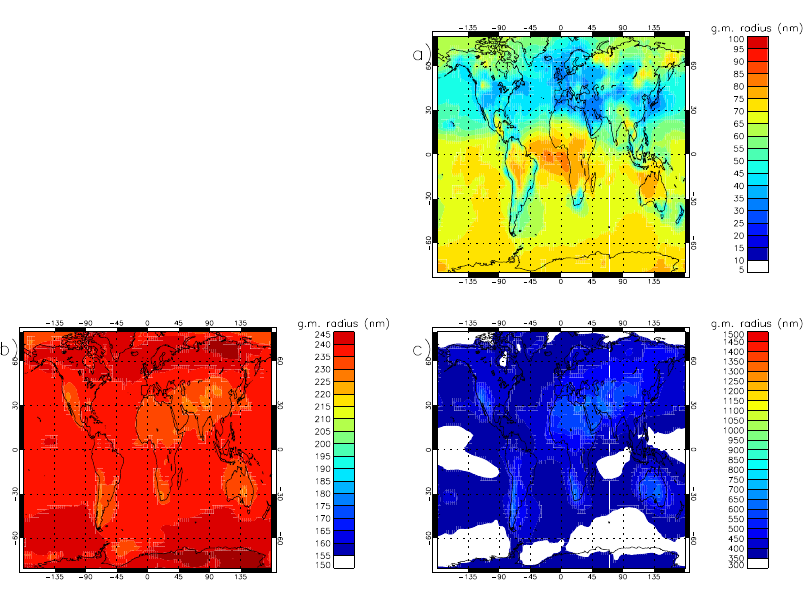
Fig. 12. Global maps of simulated annual-mean geometric mean radius in the lowest model level for (a) Aitken-insoluble mode, (b) accumulation-insoluble mode and (c) coarse-insoluble